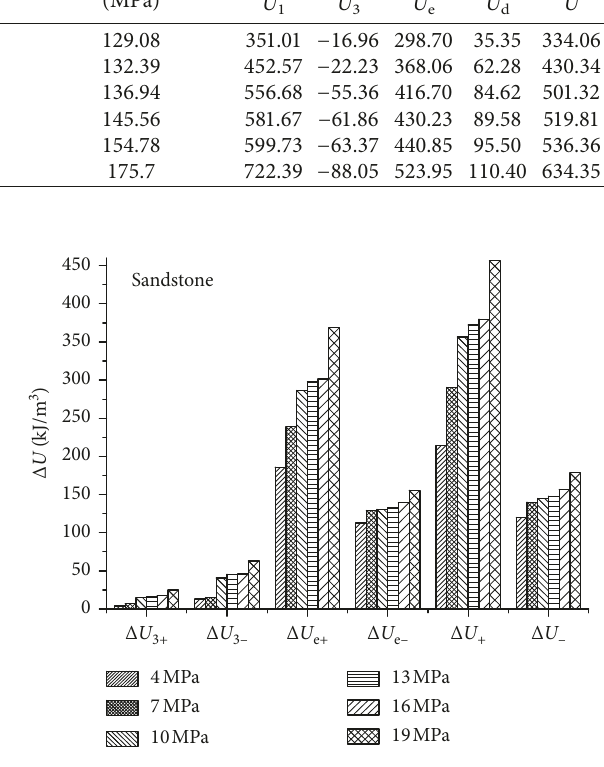
Figure 9: Energy transformation of loading and unloading con- fining pressure periods under different initial unloading confining pressures.